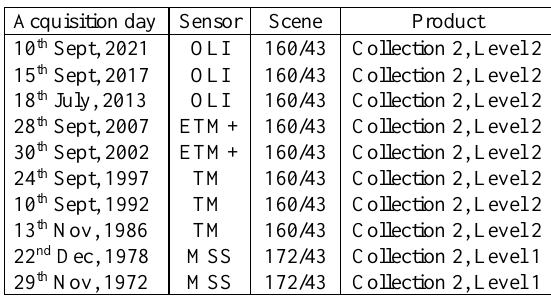
Table 1 . The selected Landsat TS images.